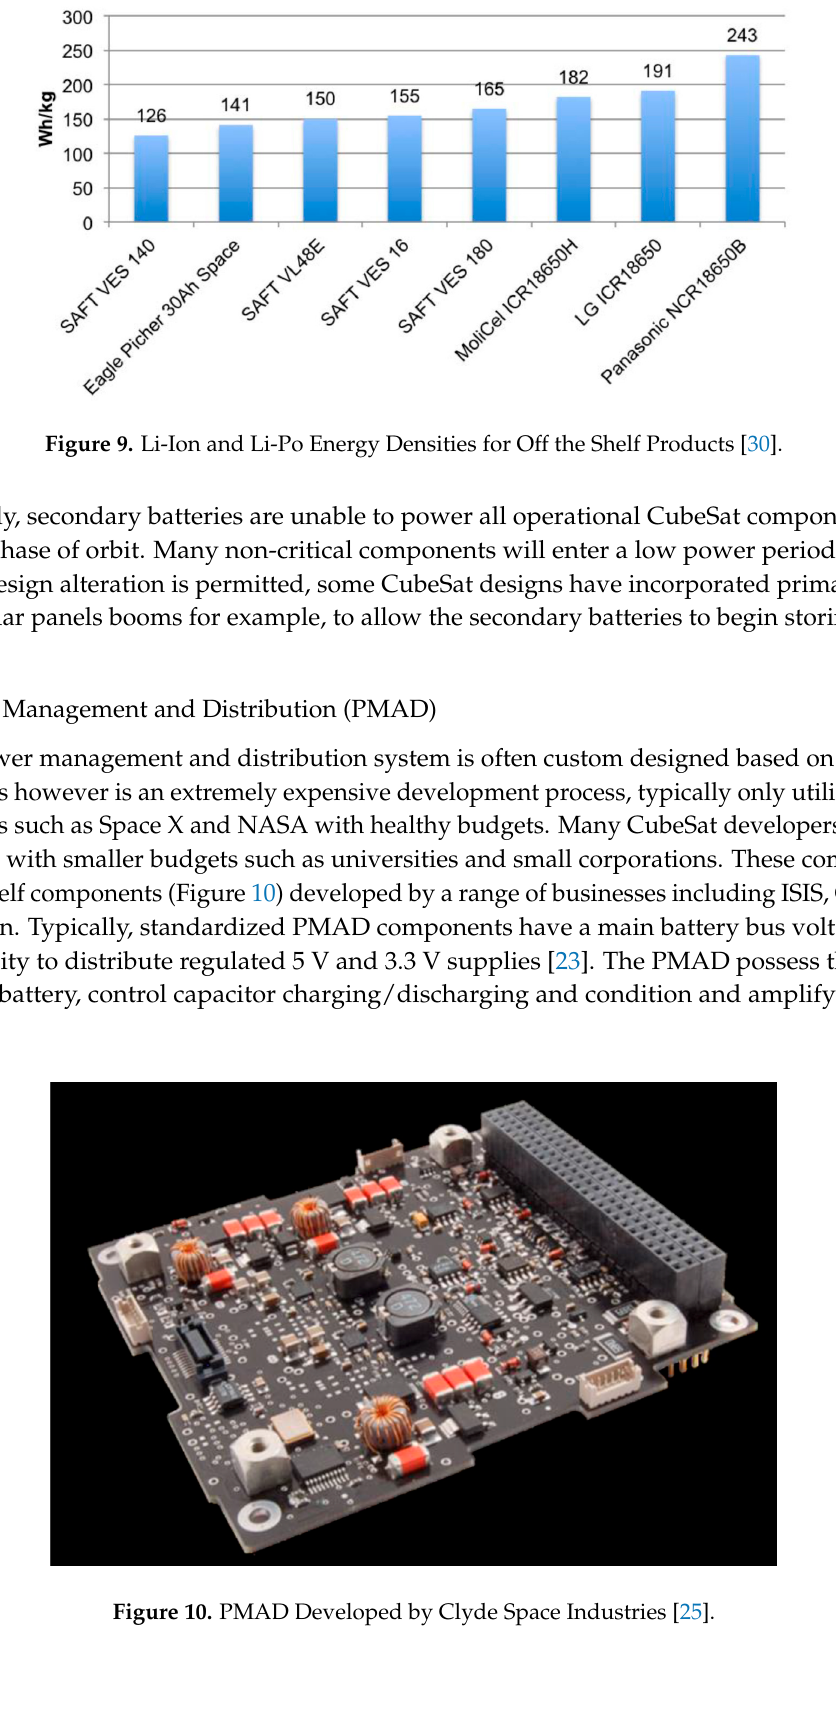
Figure 10. PMAD Developed by Clyde Space Industries [25].